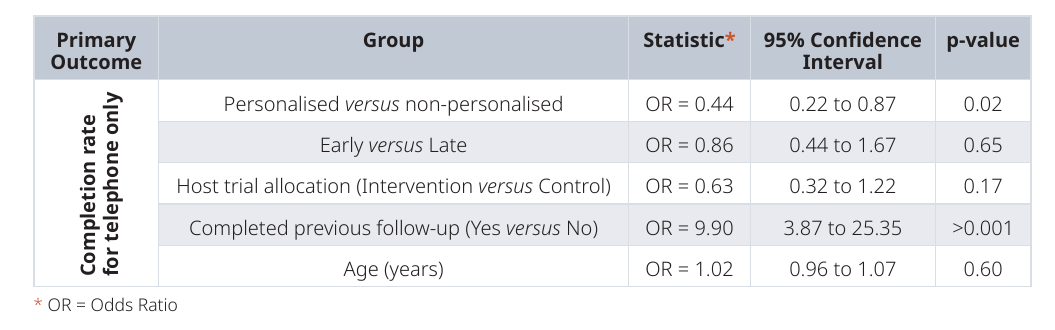
Table 3. Primary analysis results.